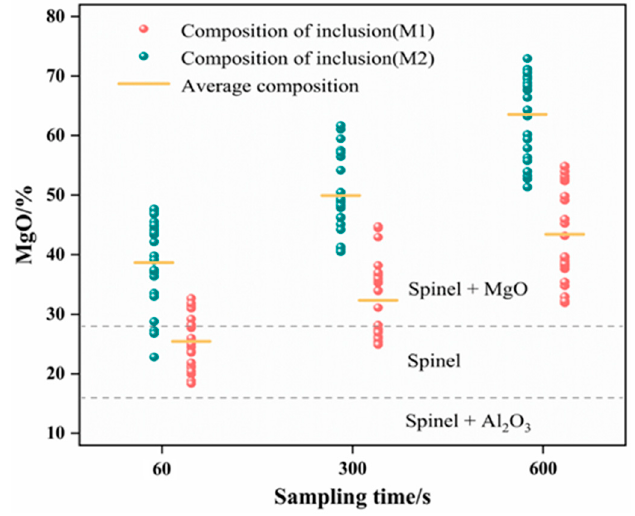
Figure 5. Inclusion composition detected after adding magnesium in high-carbon hard wire steel.